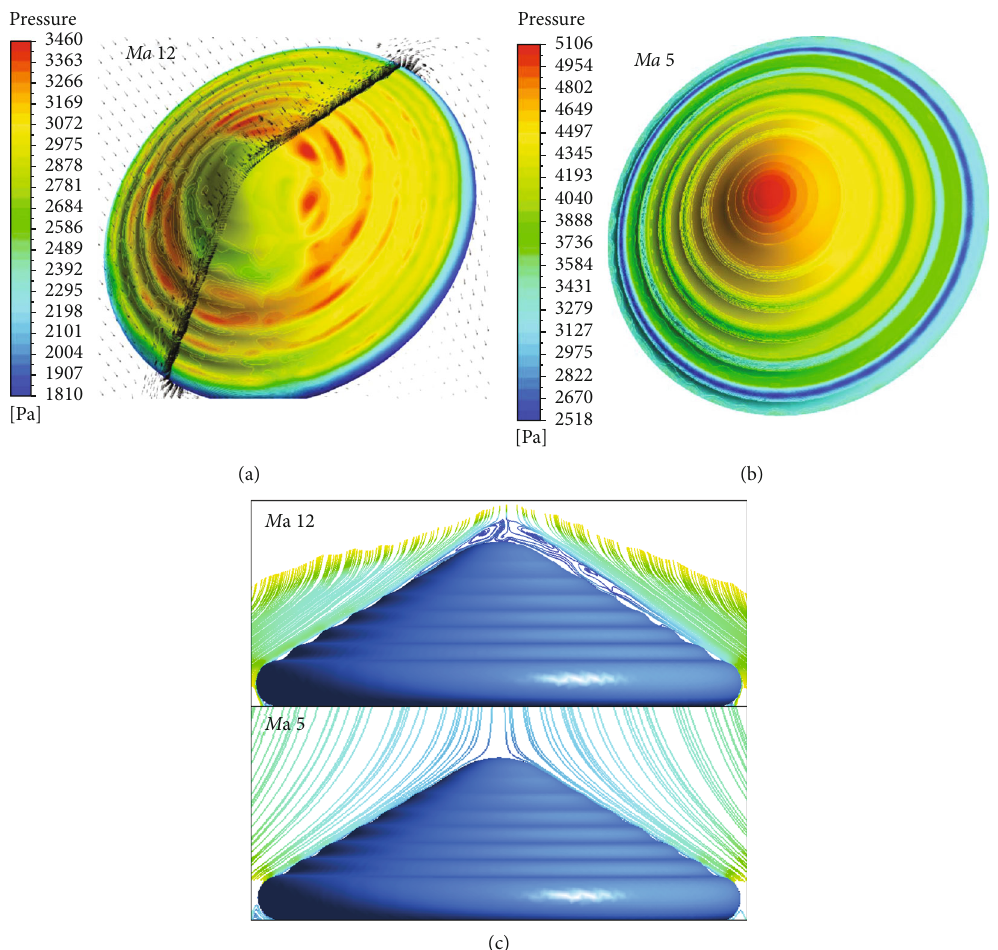
Figure 9: Flow comparison between Ma 12 and Ma 5: (a, b) surface pressure; (c) streamline. Density gradient